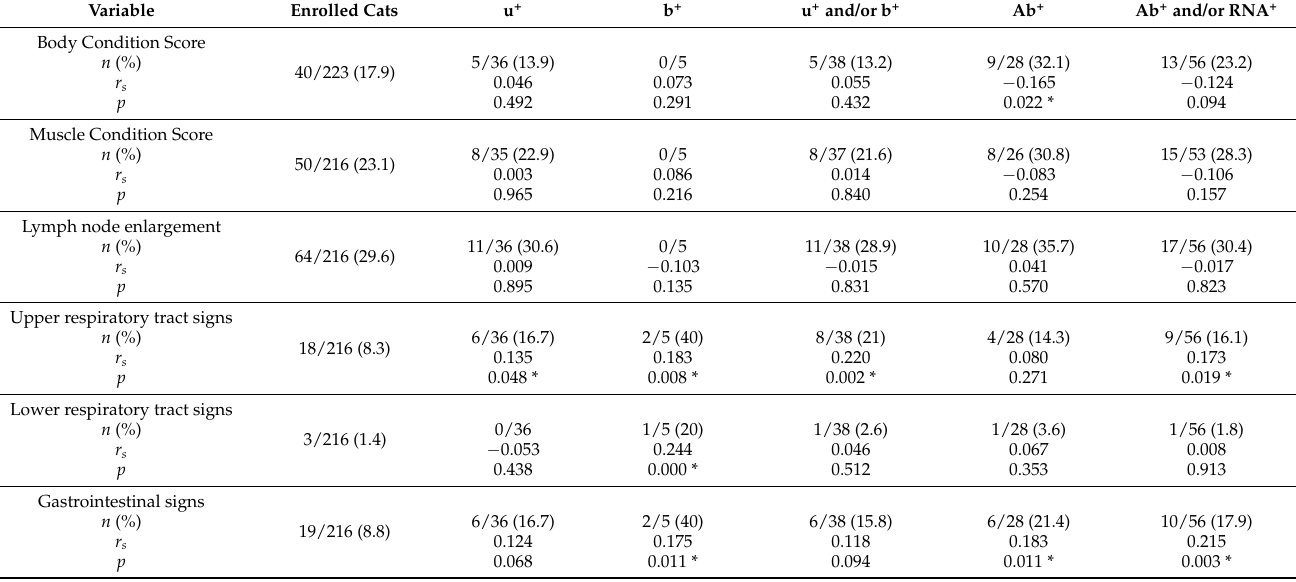
Table 3. Prevalence of clinical findings of enrolled cats and cats positive to FeMV according to their positivity by qPCR FeMV from urine (u + ), blood (b + ), urine and/or blood (u + and/or b + ), FeMV Abs (Ab + ), FeMV Abs and/or qPCR FeMV (Ab + and/or RNA + ), with description of Spearman’s rank correlation coefficient ( r s ), p values and significant difference (*).